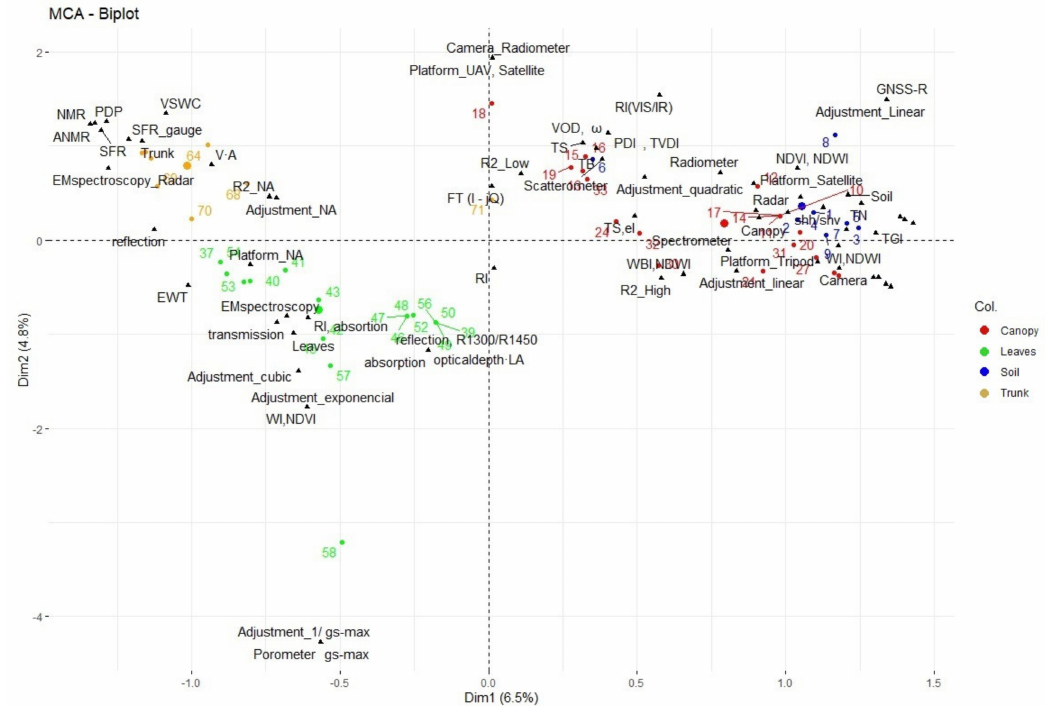
Figure 12. Biplot showing the multiple correspondence analysis (MCA) conducted on 72 studies collected in this review. Circles represent the individual studies and black triangles represent variables. Individual studies (circles) are colored according to the target of the monitoring method developed in